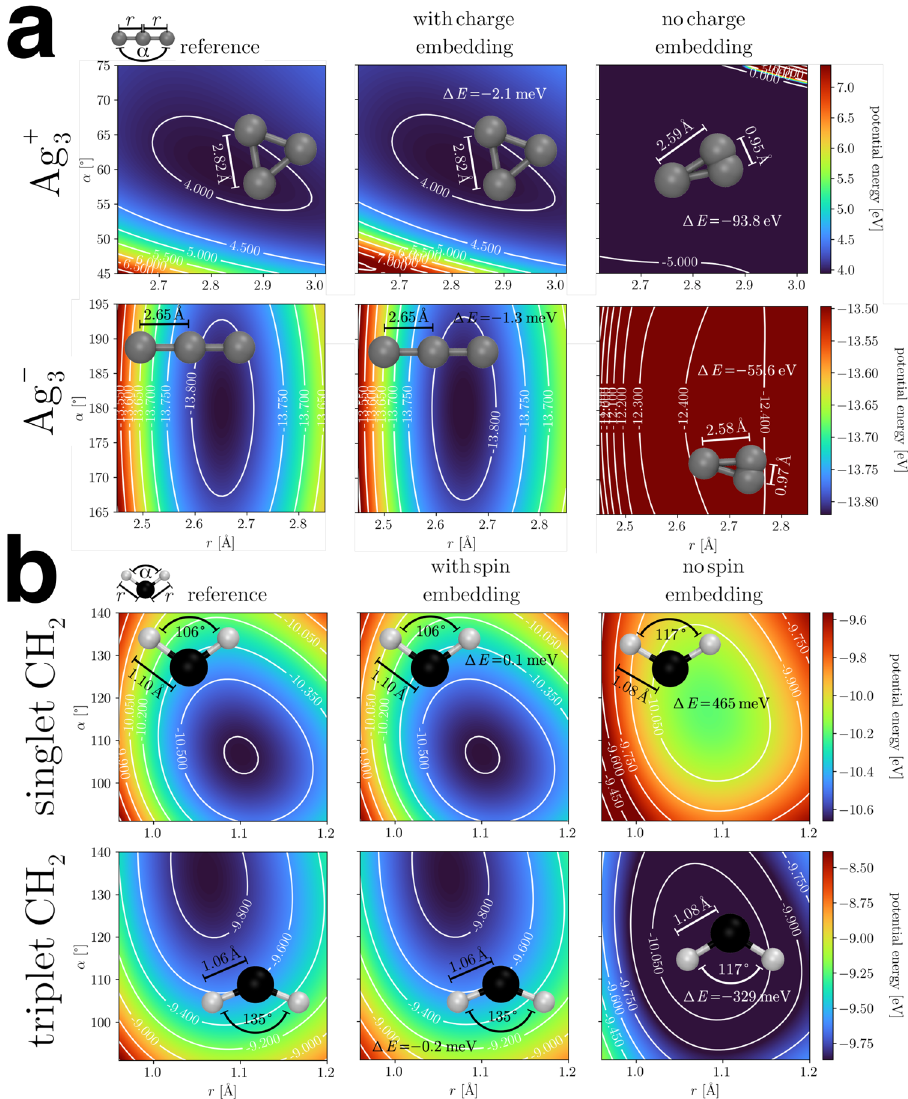
Fig. 4 Potential energy surfaces of a Ag þ and Ag (cid:2) and b singlet and triplet CH 2 . The middle and right columns show the prediction of SpookyNet with 3 3 and without charge/spin embedding, respectively, whereas the reference ground truth is shown in the left column. Minimum energy structures and prediction errors ( Δ E ) for the minimum energy are also